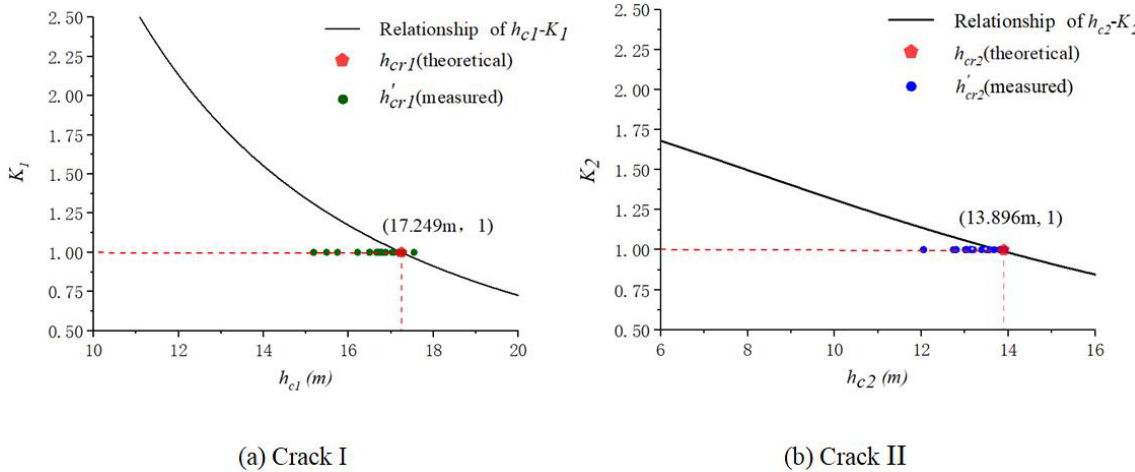
Figure 10. Comparison of h (cid:48) cr (measured) and h cr